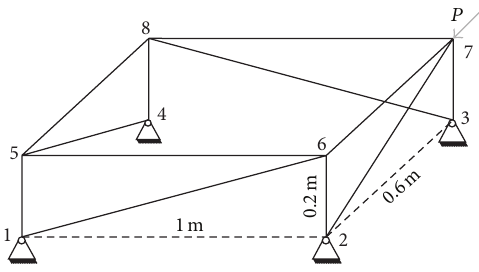
Table 1: Natural intervals of the space frame